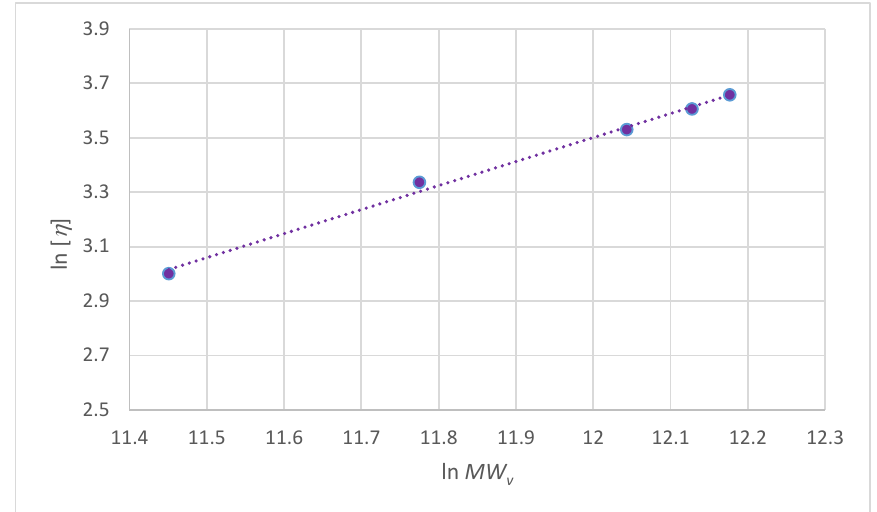
Figure 7. Plot of ln [ η ] vs. ln MW v . R 2 = 0.9901.